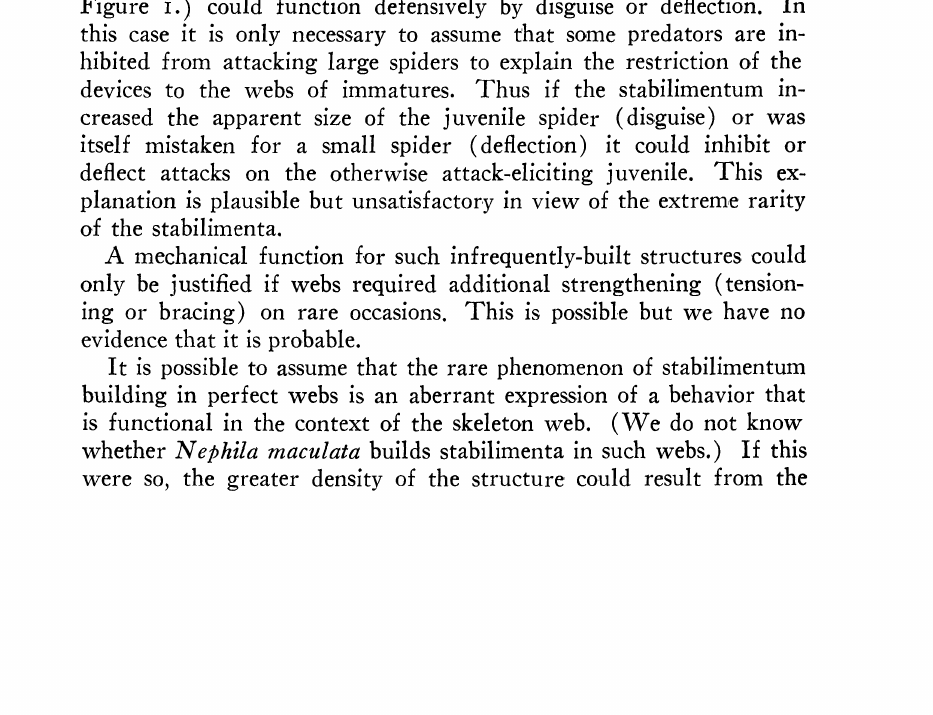
Of stabilimentum building to the skeleton webs of immature Nephila